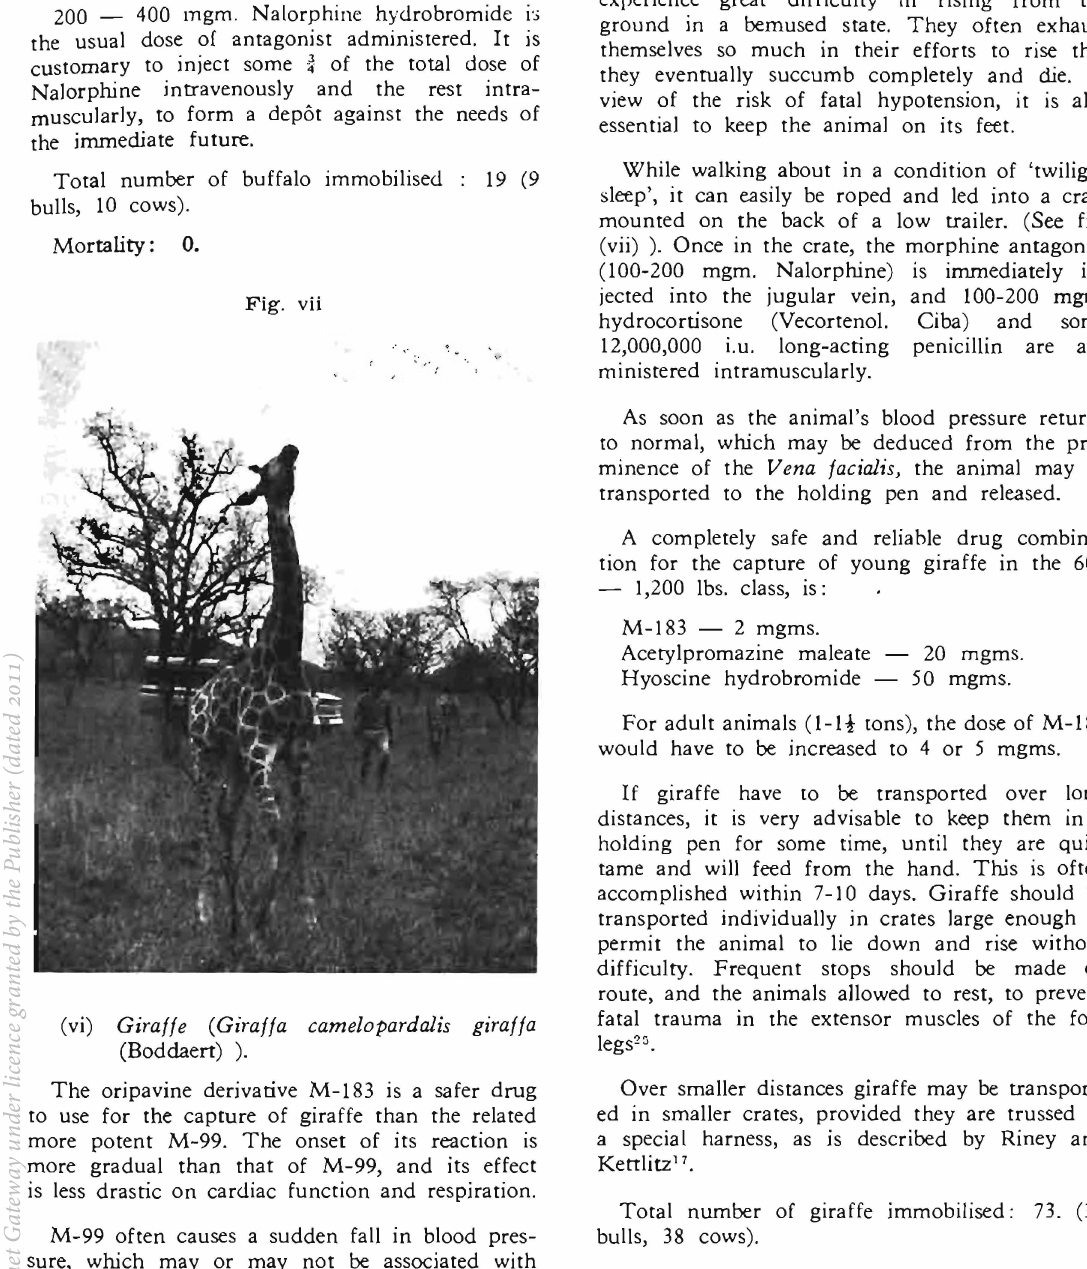
(vi) Giraffe (Giraffa camelopardalis